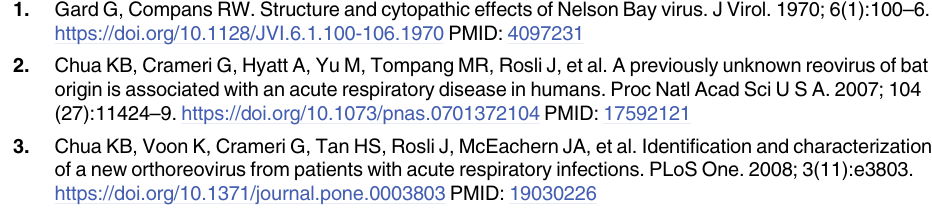
S5 Table. Neutralization titers of bat sera for Nachunsulwe-57. S6 Table. Amino acid sequence identities of encoded proteins between Nachunsulwe-57 and